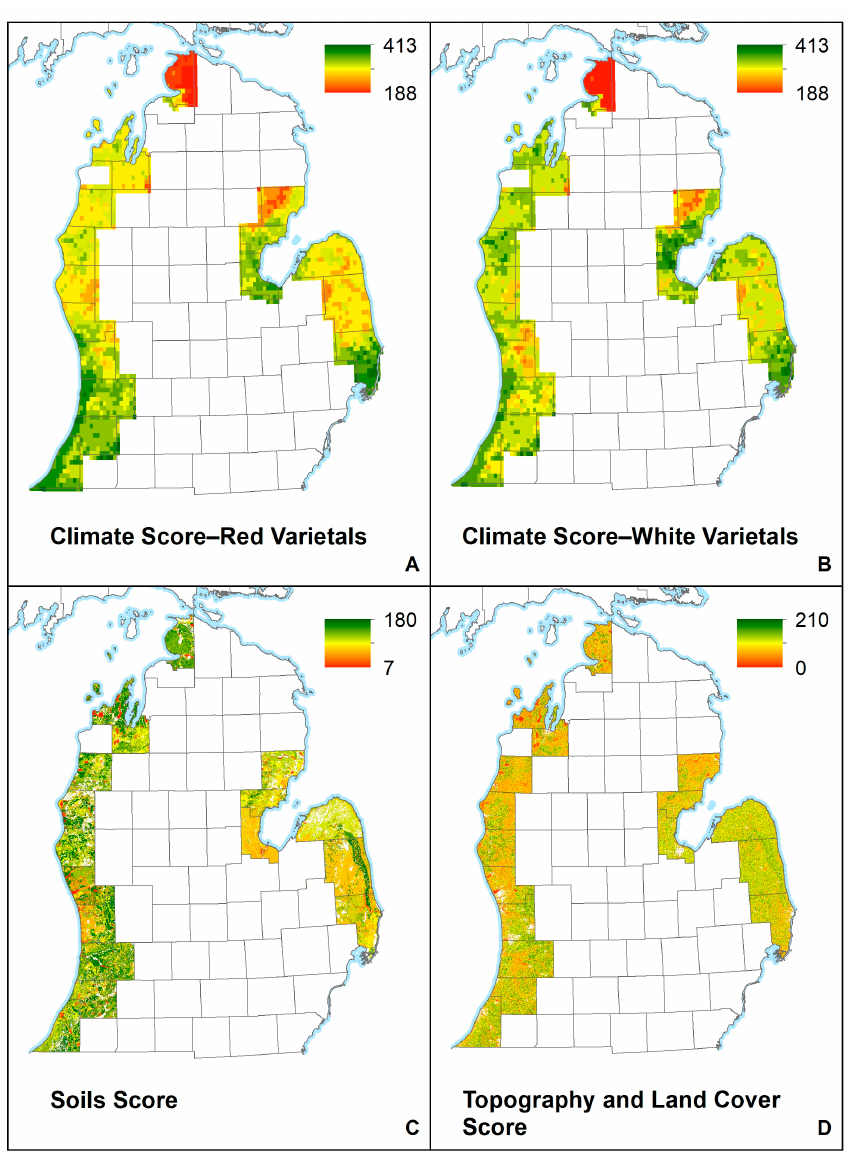
Figure 6. The final scoring for the three main categories of the model input data including: climate ( A and B ), soil ( C ), and topography/land cover ( D ) variables. The upper portion of the map highlights the climate scoring difference between red ( A ) and white ( B ) vinifera.